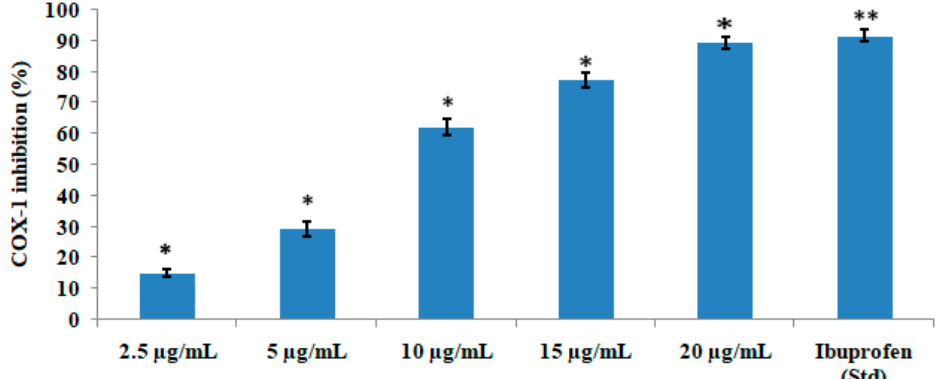
Figure 4. COX-1-inhibitory activities of various concentrations of quercetin-3-methoxy-4 ′ -glucosyl-7- glucoside. The results represent mean ± SEM (n= 3). * p < 0.05 and ** p < 0.01 compared to the control group.